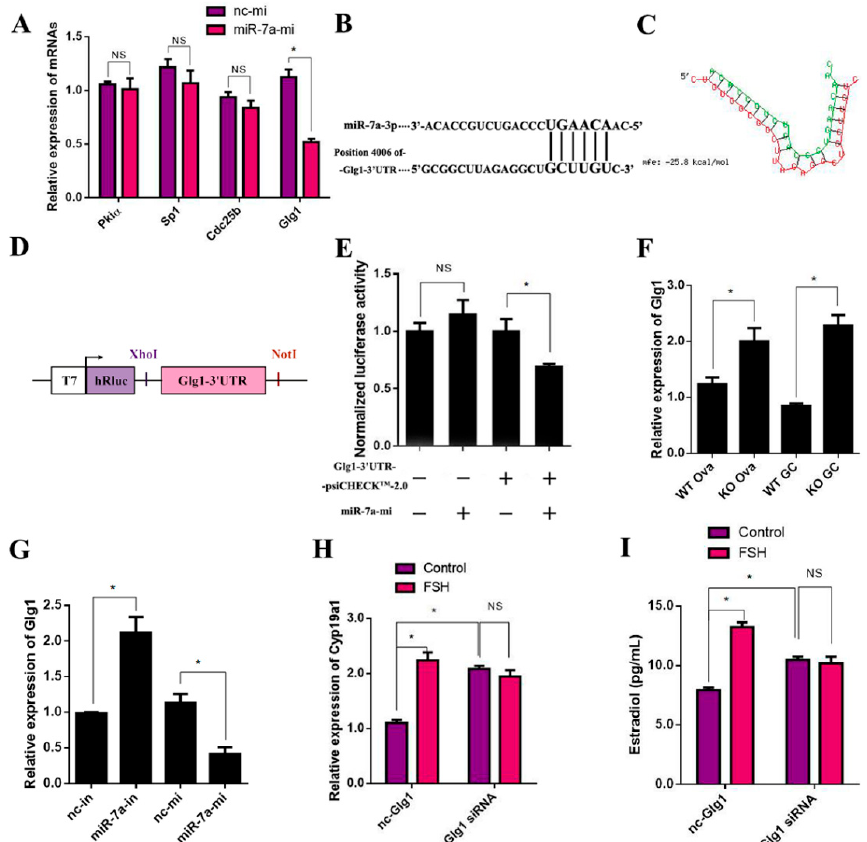
Figure 8. Glg1 is the direct target of miR-7a in ovarian granulosa cells. ( A ) Relative mRNA levels of Pki α , Sp1 , Cdc25b , and Glg1 were detected by RT-qPCR and normalized to GAPDH ; n = 3. ( B ) The predicted binding sites of miR-7a and 3 ′ -UTR of Glg1 . ( C ) Schematic representation of the hybridization between miR-7 and Glg1 3 ′ -UTR and the predicted minimum free energy, as calculated by RNA hybrid. Green letters indicate miR-7a sequences, and red letters indicate Glg1 sequences. ( D ) Schematic of the inserted GLG1 3 ′ -UTR sequences into the psiCHECK TM -2.0 vector. ( E ) The relative luminescence intensity detected using a dual-luciferase reporter assay kit after the co-transfection of miR-7a-mi or nc-mi and the dual-luciferase vectors into 293FT cells; n = 3. ( F ) Relative Glg1 mRNA levels were detected by RT-qPCR and normalized to GAPDH ; n = 3. ( G ) Relative Glg1 mRNA levels were detected by RT-qPCR and normalized to GAPDH ; n = 3. ( H ) Cyp19a1 mRNA levels in cells were analyzed by RT-qPCR and normalized to GAPDH ; n = 3. ( I ) E 2 levels in the culture medium were examined by RIA; n = 3. Data are presented as mean ± SEM. * p < 0.05. NS, not significant.